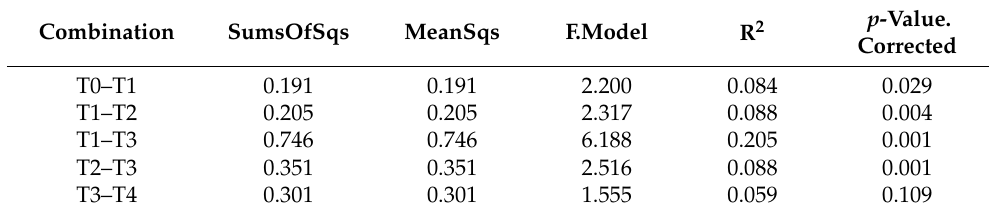
Table 2. Statistical analysis of the effect of aging on beta diversity based on Bray-Curtis distance matrix.